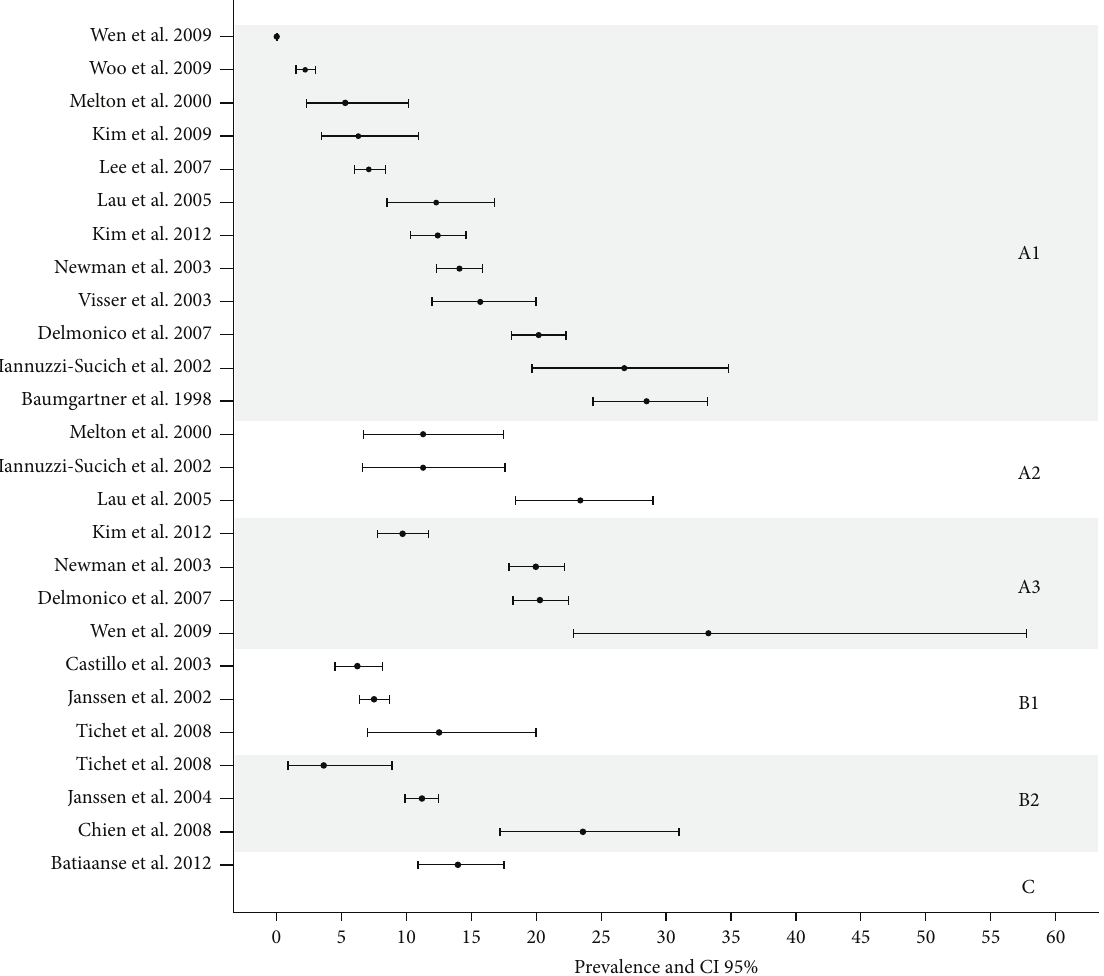
Figure 3: Sarcopenia prevalence and CI 95% in men. (A: DEXA; A1: appendicular skeletal muscle mass index (AMMI); A2: total skeletal muscle mass index (AMMT); A3: residuals method; B: BIA; B1: skeletal muscle index/height; B2: skeletal muscle index/weight; C: calf